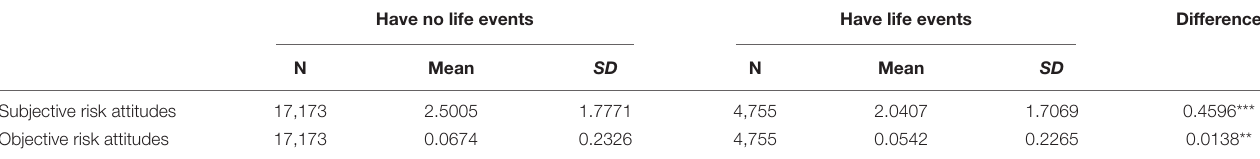
TABLE 10 | Mean test.